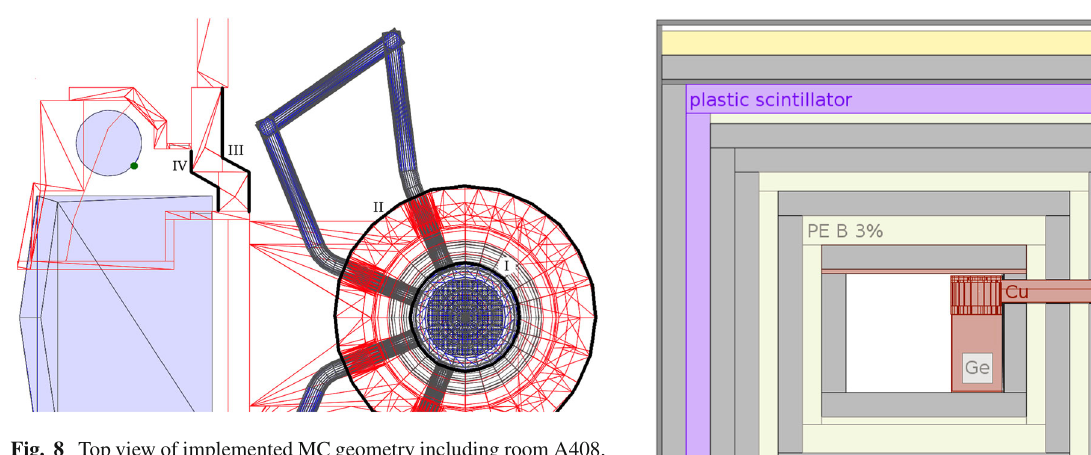
Fig. 8 Top view of implemented MC geometry including room A408, the overburden and the reactor core with surrounding. Concrete struc- tures are displayed in red, the blue areas correspond to the spent fuel storage pool and the cask for shipment of spent fuel assemblies. For simplification only two of the four loop pipes are implemented (only selected volumes are displayed for a better overview)